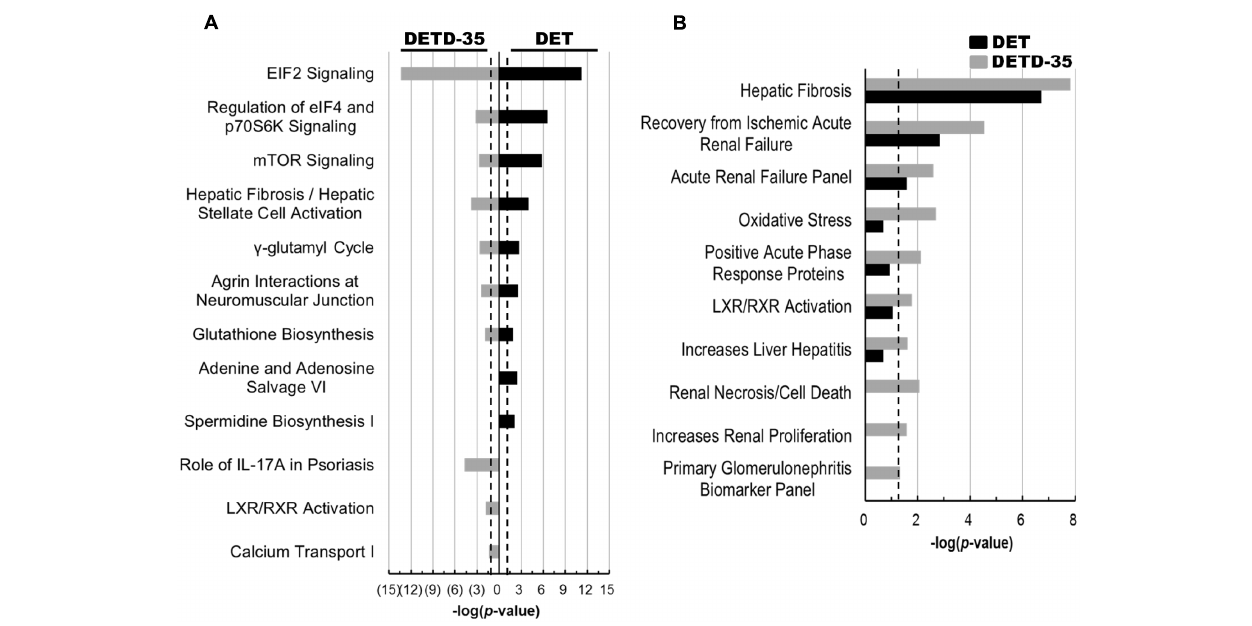
FIGURE 6 | Canonical pathways and toxicity lists of differentially expressed compound-responsive exosomal proteins generated by IPA database analysis. The significant canonical pathways (A) and toxicological events (B) of the differentially expressed exosomal proteins responsive to both compound treatments were performed using IPA database analysis. The –log( p -value) of 1.3 ( P < 0.05) was considered as statistical significance in IPA analysis. The black dotted line indicates –log( p -value) value of 1.3 as the threshold.